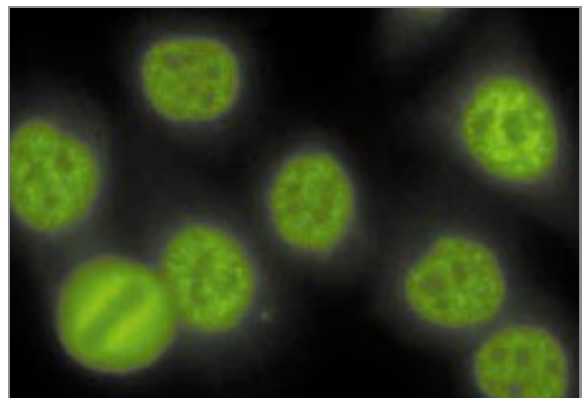
Figura 6 – Nuclear pontilhado grosso